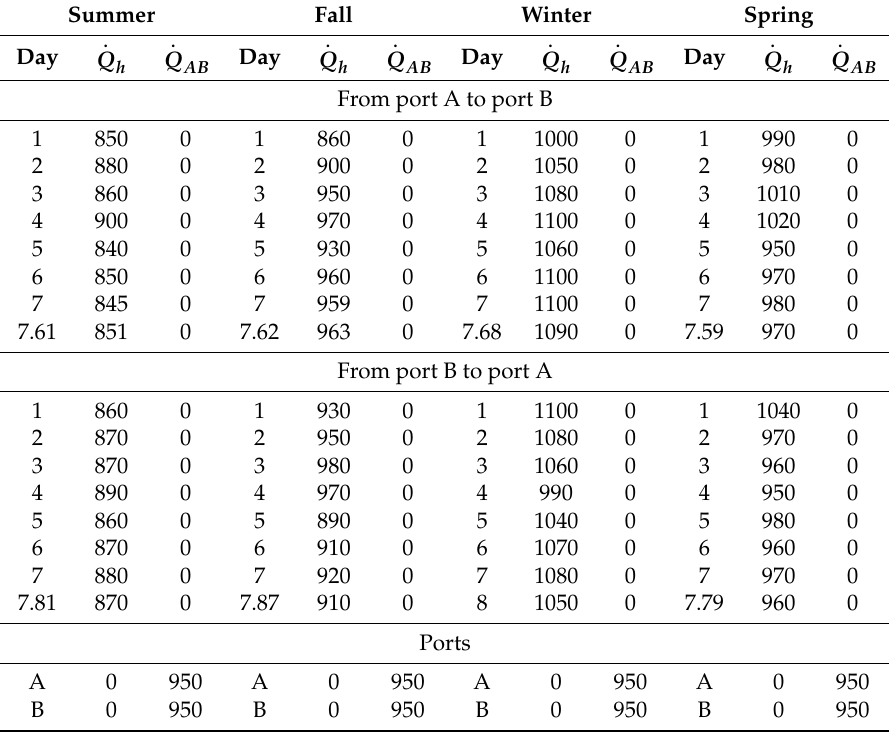
Table 32. Contribution of the HRSG and auxiliary boiler to thermal loads versus time for all seasons (in